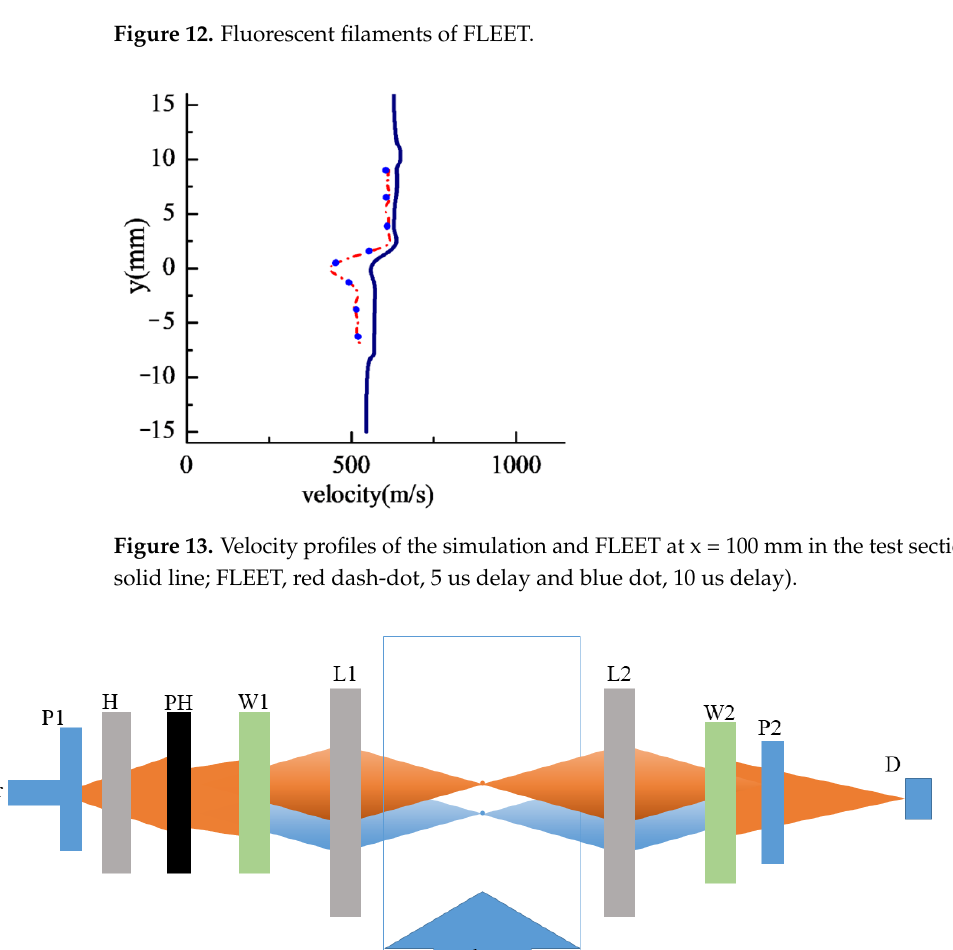
Figure 15. Power spectrum of the density at the measuring point. ( a ) Simulation, ( b ) FLDI, ( c ) the detection point. 6. Conclusions This paper describes the design process of a supersonic-supersonic mixing layer wind tunnel for the research into mixing layers and the application of newly developed optical measurement techniques. Large eddy simulation played an important role in eval- uating the design, illustrating the flow field of the supersonic-supersonic mixing layer and analyzing the performance of FLEET and FLDI. Mach numbers were calibrated by pressure measurement, and it was determined that the wind tunnel was able to generate the desired flow, with a deviation of Mach numbers of less than 0.1 compared to the design numbers. The pressure distribution in the stream- wise direction of the simulation was compared to the experimental data, and showed a slightly decreasing trend. The pressure drop was about 15%. However, probably due to the assumption of a perfect gas and the non-slip wall, the pressure of the simulation was slightly larger than the experiment, requiring further in-depth research. The velocity of the simulation was lower than FLEET, perhaps for the same reason, and needs further study and modification. FLDI and the simulation showed good agreement in the power spectrum of the density fluctuation, which verified the practical application of the tech- nique. As far as we know, this is the first time that numerical simulation results have been compared with FLEET and FLDI in a supersonic-supersonic mixing wind tunnel.